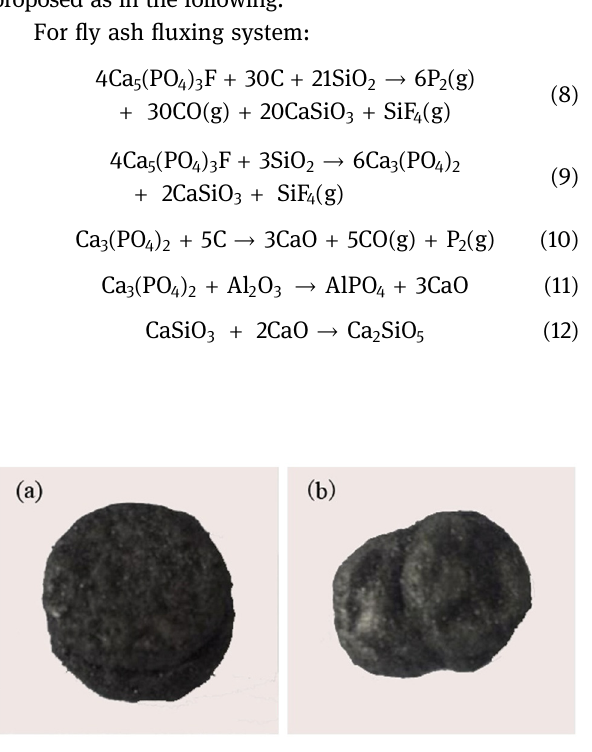
Figure 9: Optical images of residue of SiO 2 system slag ( a ) and fl y ash system slag ( b )